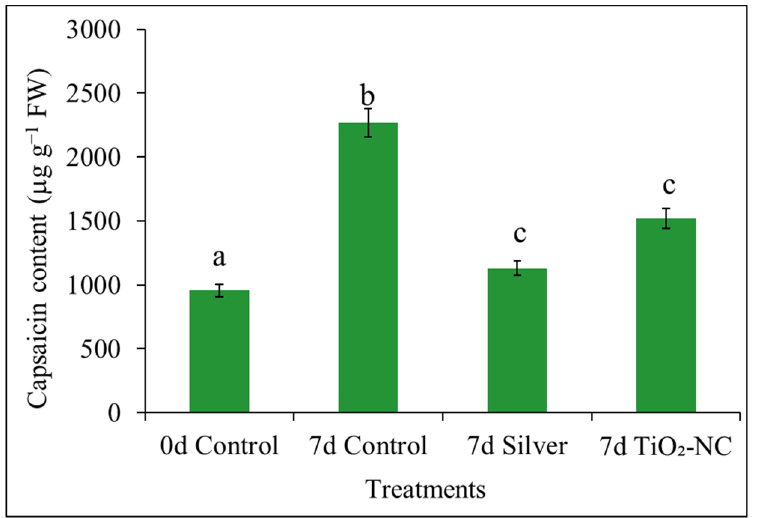
Figure 11. Capsaicin content of Capsicum fruit recorded under silver and TiO 2 -NC with respect to control during 0 d and 7 d of postharvest storage at 25 °C. Vertical bars showing SE ± 1 ( n = 3) on each column and letters above bars indicate statistical variations between treatments based on one way ANOVA ( p ≤ 0.05).